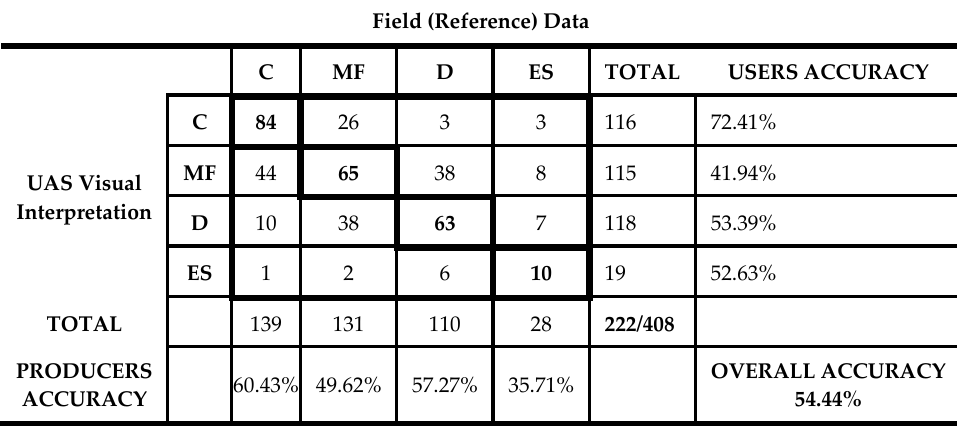
Table 3. Plot-level forest composition thematic accuracy for UAS visual interpretations of four classes.